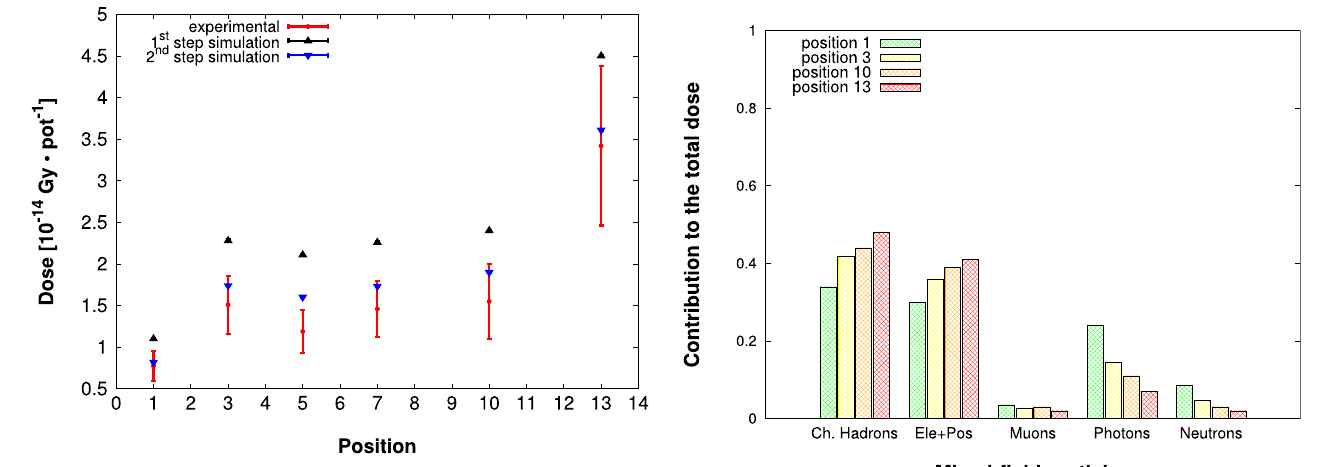
Fig. 5. Experimental and simulated doses – 1st and 2nd step simulations – at different test positions, cp_0000 con fi guration. Table 5. Experimental and 2nd step simulated doses in 10 (cid:4) 14 Gy/pot, in different positions at CHARM. Position